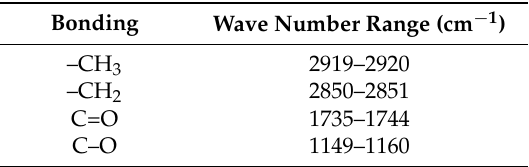
Figure 3. Fourier transform infrared spectroscopy (FT-IR) absorption spectra of Mixed SSPCMs. Table 3. FT ‐ IR absorption spectra peaks of Mixed SSPCMs.